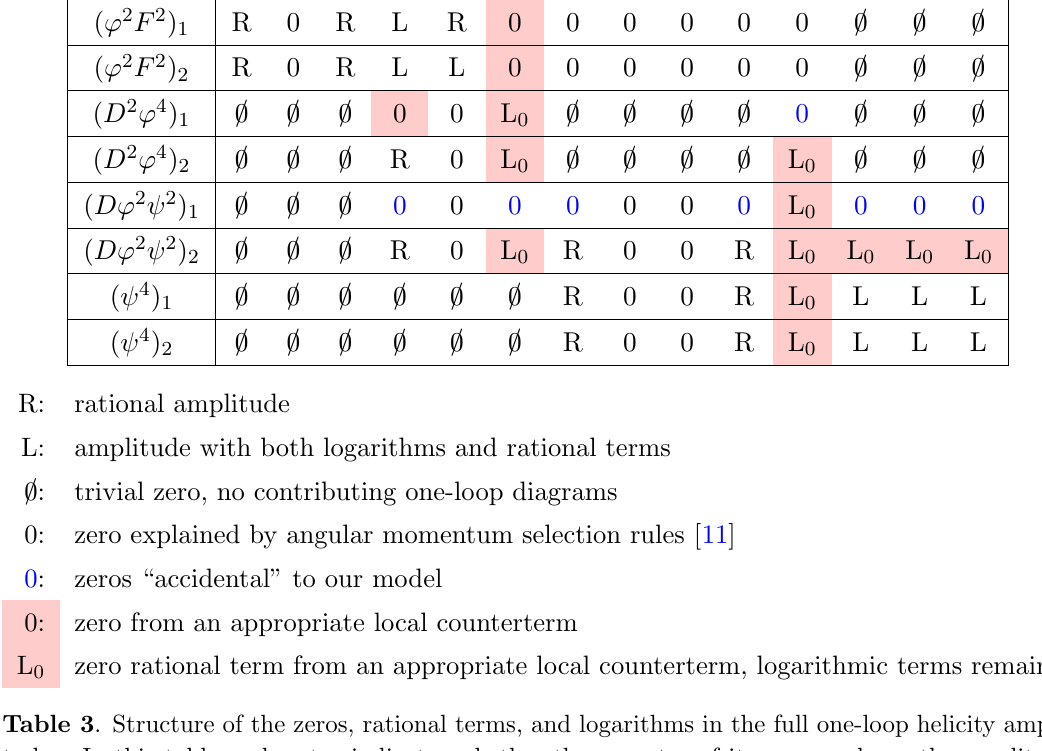
Table 3 . Structure of the zeros, rational terms, and logarithms in the full one-loop helicity ampli- tudes. In this table each entry indicates whether the operator of its row produces the amplitude with external state corresponding to its column. V denotes a vector boson, a fermion and ’ a